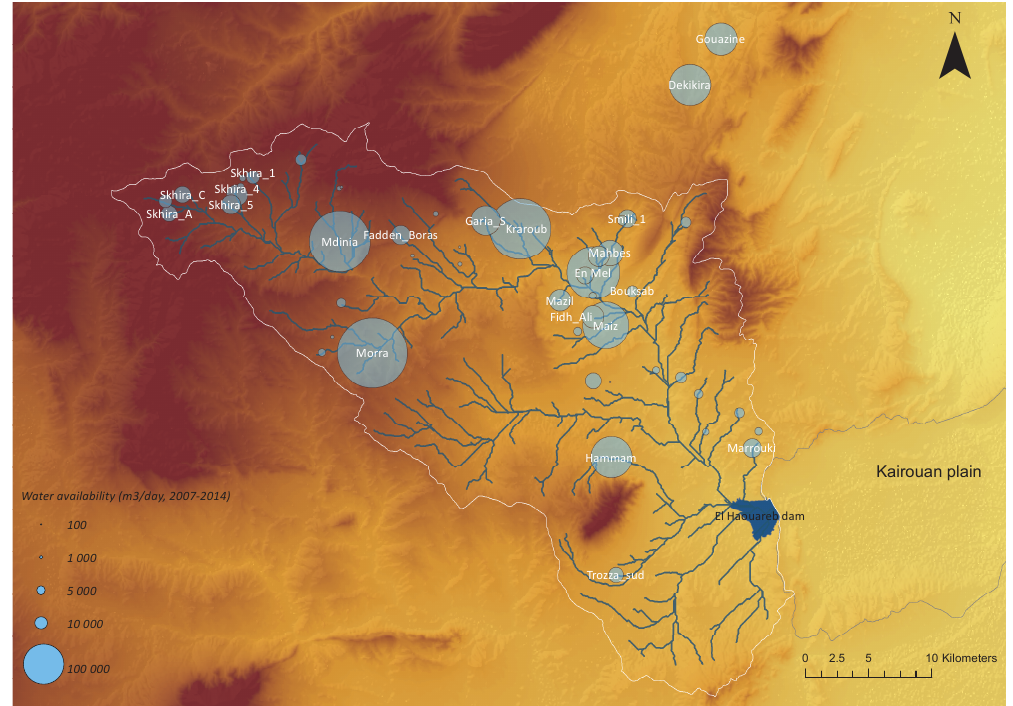
Figure 20. Mean water availability of lakes within the Merguellil upper